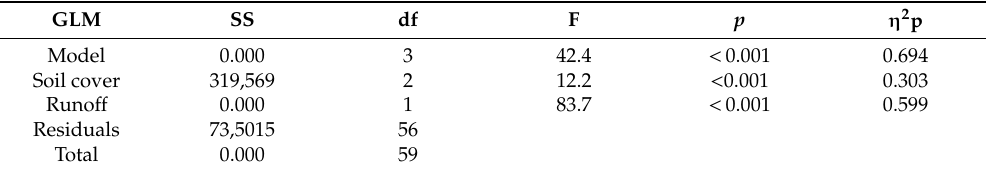
Table 4. Summary results of the general linear model (GLM) of the significant